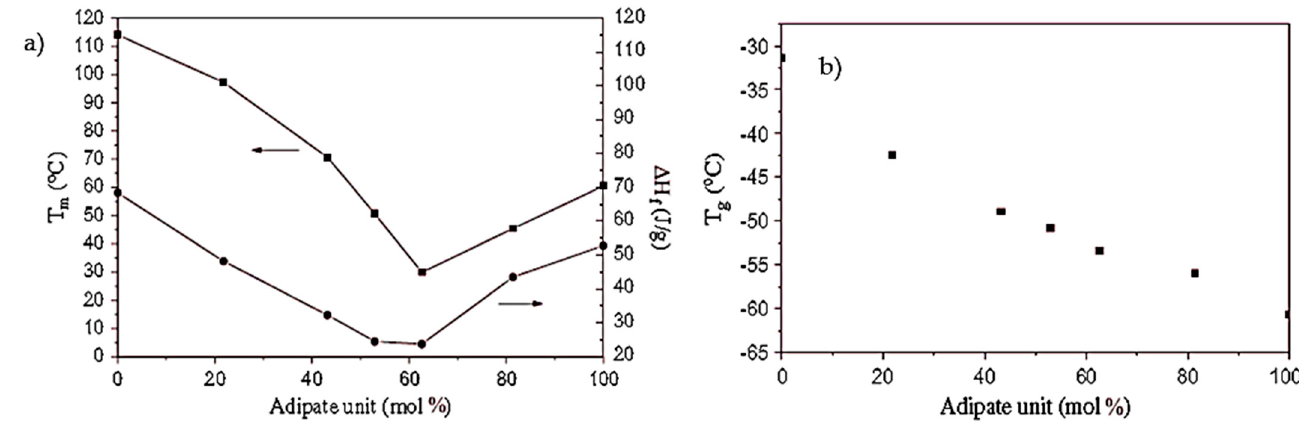
Figure 6. ( a ) Copolyester melting temperature and heat of fusion as a function of the composition. ( b ) Copolyester glass transition temperature as a function of the composition. [Reprinted with permission from Reference [6] Copyright 2001 Wiley].